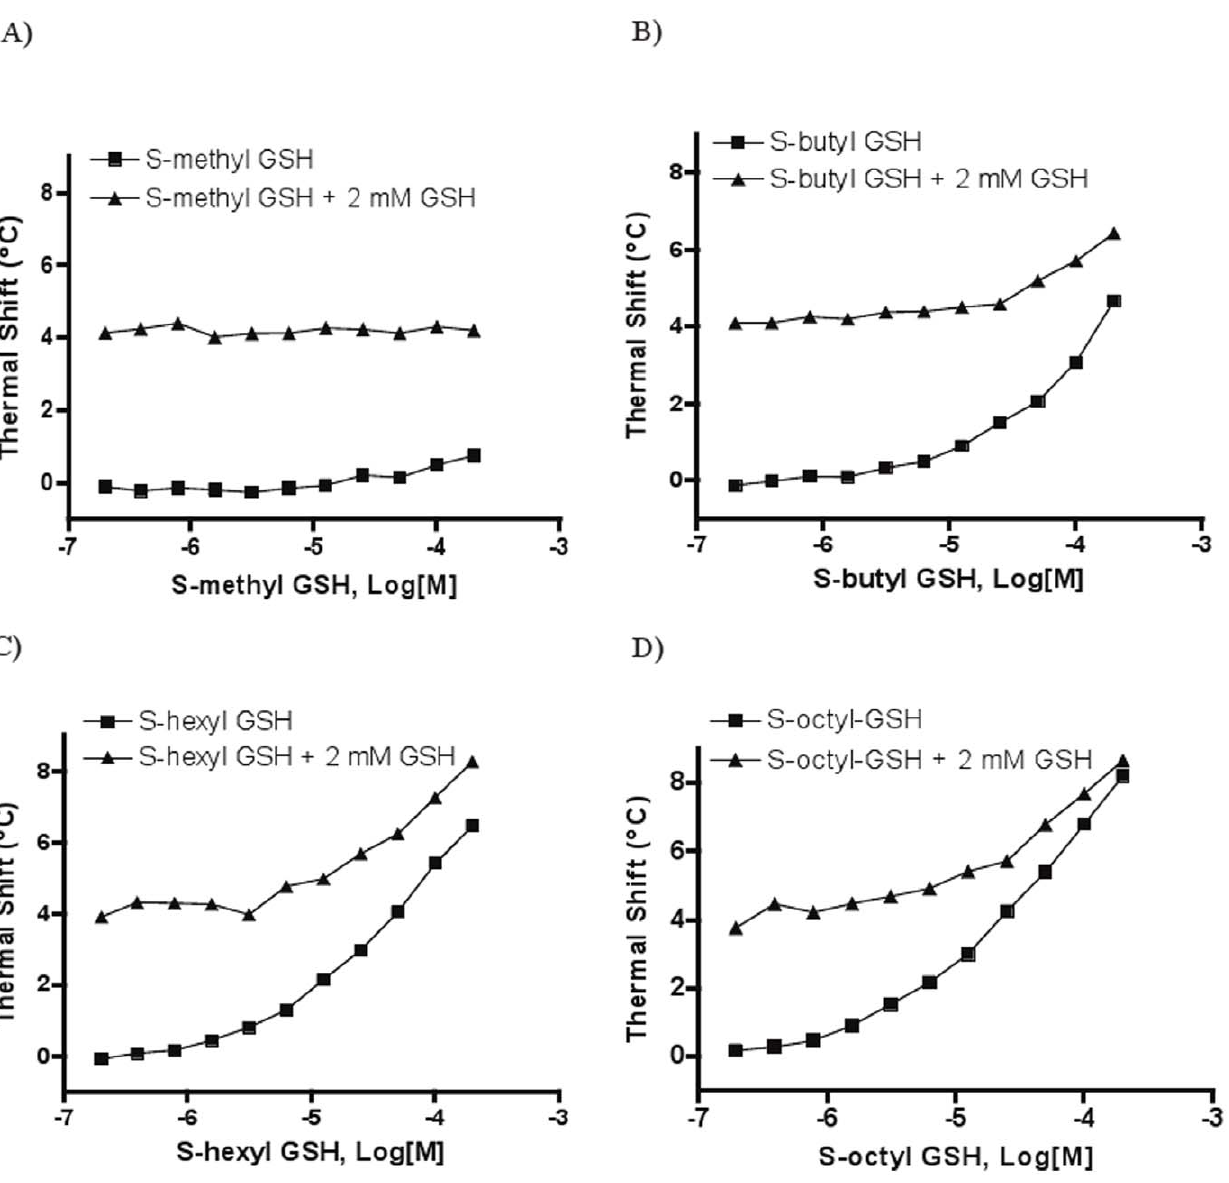
Figure 3. Thermal shift concentration-response curves for S-alkyl GSH using Sj GST: A) S-methyl GSH, B) S-butyl GSH, C) S-hexyl GSH, D) S-octyl GSH. Thermal shifts represent the differences in T m between vehicle control and compound-containing samples,